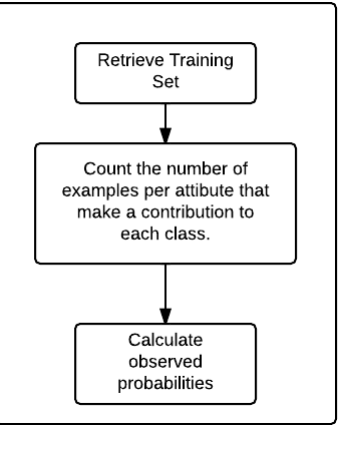
Figure 2. Naive training algorithm block diagram for a binary class dataset [18].